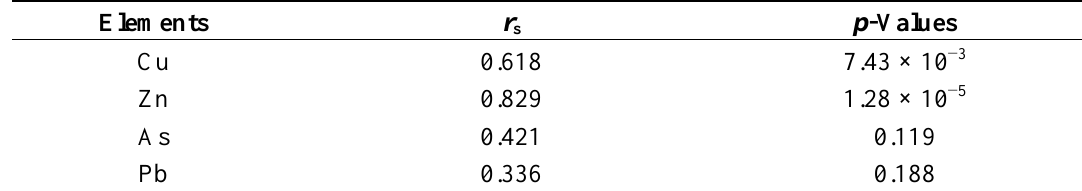
Figure 9. QQ plots of heavy metal concentrations of lichens and the corresponding substrata and the logarithmic data. The p -values were obtained by Shapiro-Wilk normality test. n = 18. Table 2. Spearman’s correlation rho and p -values of the scattered plots of Cu, Zn, As, and Pb concentrations in the lichens and the corresponding substrata. n =